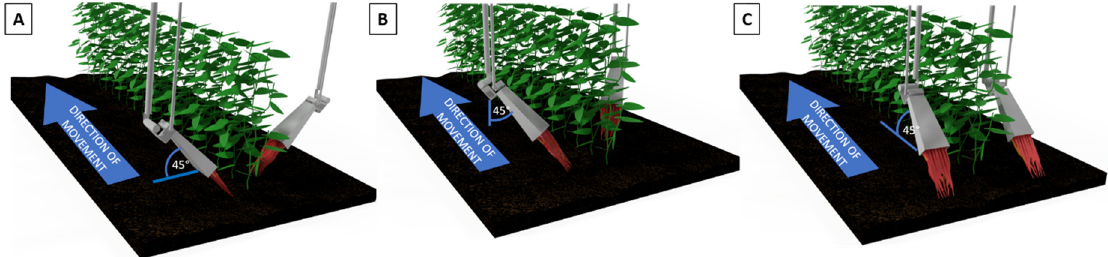
Figure 3. Schematic representation of cross (A), back (B), and parallel (C) burner orientation.